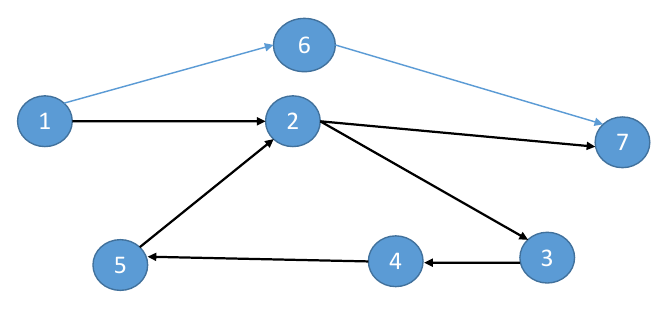
Figure 2. Non Elementary